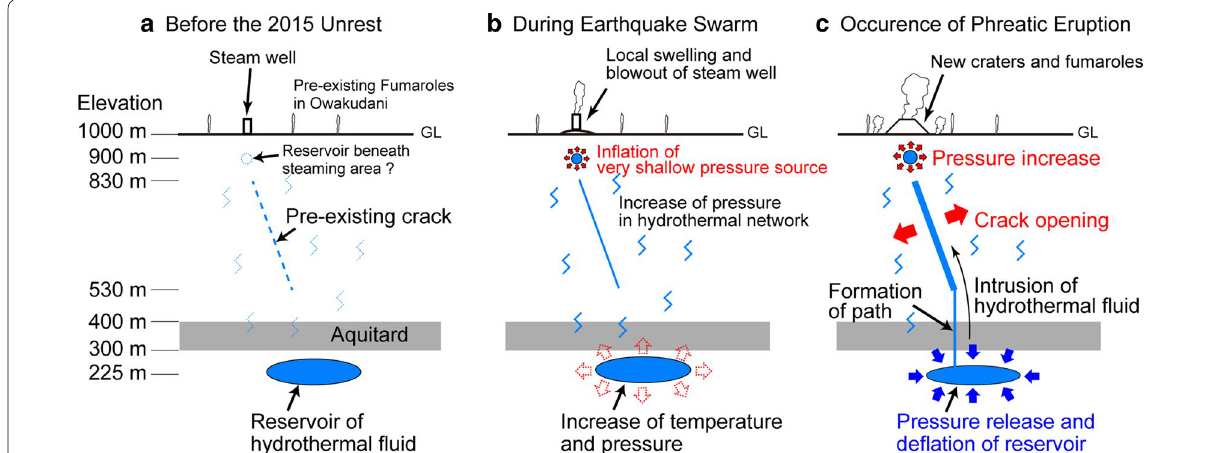
Fig. 10 Conceptual diagram of the 2015 volcanic activity of Hakone Volcano inferred from the data modeling of InSAR images. a The reservoir of hydrothermal fluid (elevation of about 225 m) and the crack (elevation of 530–830 m) originally existed before the earthquake swarm. b Tempera- ture and pressure possibly rose in the reservoir of hydrothermal fluid during the swarm activity, and an increase in pressure possibly occurred in the hydrothermal network. A small quantity of water or steam was uplifted to the ground surface and caused the very local swelling and the abnormal blowouts of steam wells. c When a path between the reservoir and crack formed, the hydrothermal fluid intruded from the reservoir to the crack. The released pressure in the hydrothermal system caused inflation of a very shallow source located the northernmost part of the crack and resulted in the phreatic